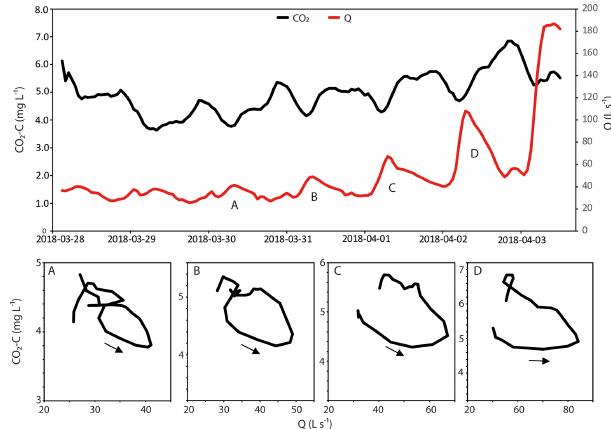
Figure 5. Stream CO 2 concentration (black) and discharge (red) for the snowmelt period 2018 with CO 2 – Q hysteresis plots for four discharge events.